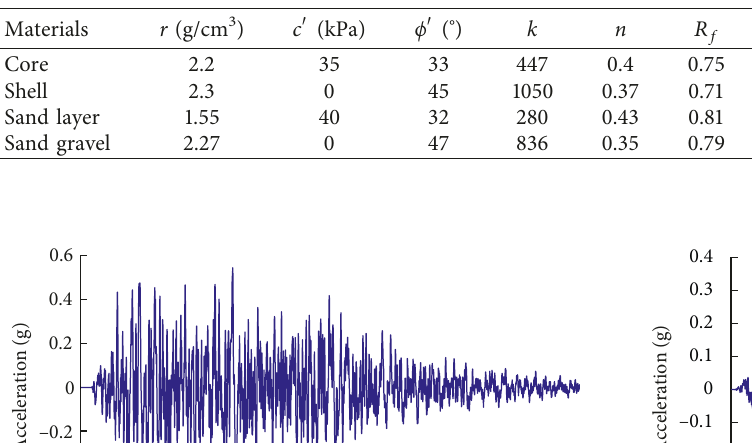
Table 7: Parameters of the E - μ model and equivalent linear model.